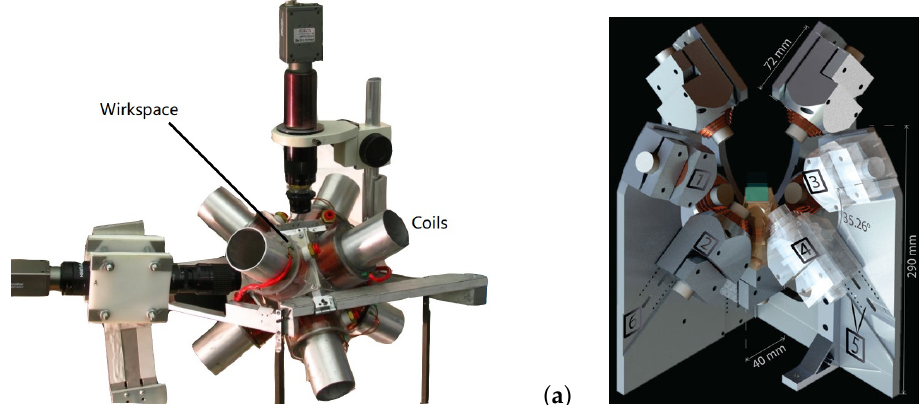
Figure 18. EMA platform developed with independent control: ( a ) a photograph of the EMA setup comprising 8 electromagnetic coils [95]; and ( b ) a photograph of the nine-coils EMA system